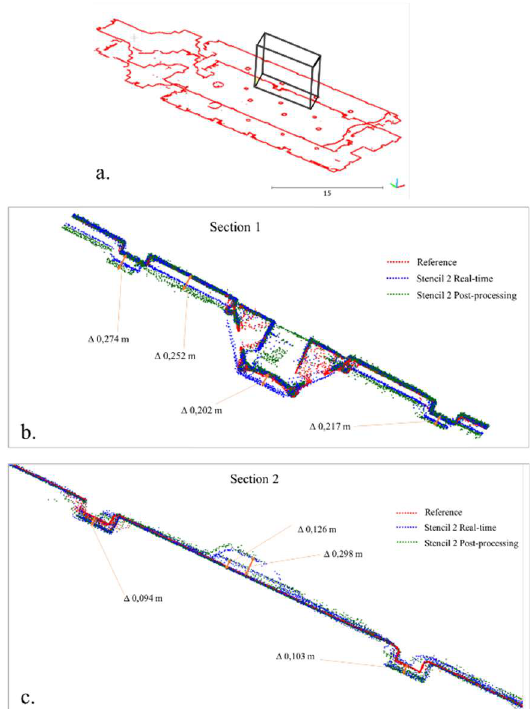
Figure 12. Comparison between the profiles of the reference point cloud, the Real-time Stencil 2 solution and the point cloud obtained after the data reprocessing. In (a.) it are highlighted the analysed sections; (b.) shows the deviation of the double surfaces at an height of 1,70m; (c.) shows the deviation of the double surfaces at an height of 3,70m.